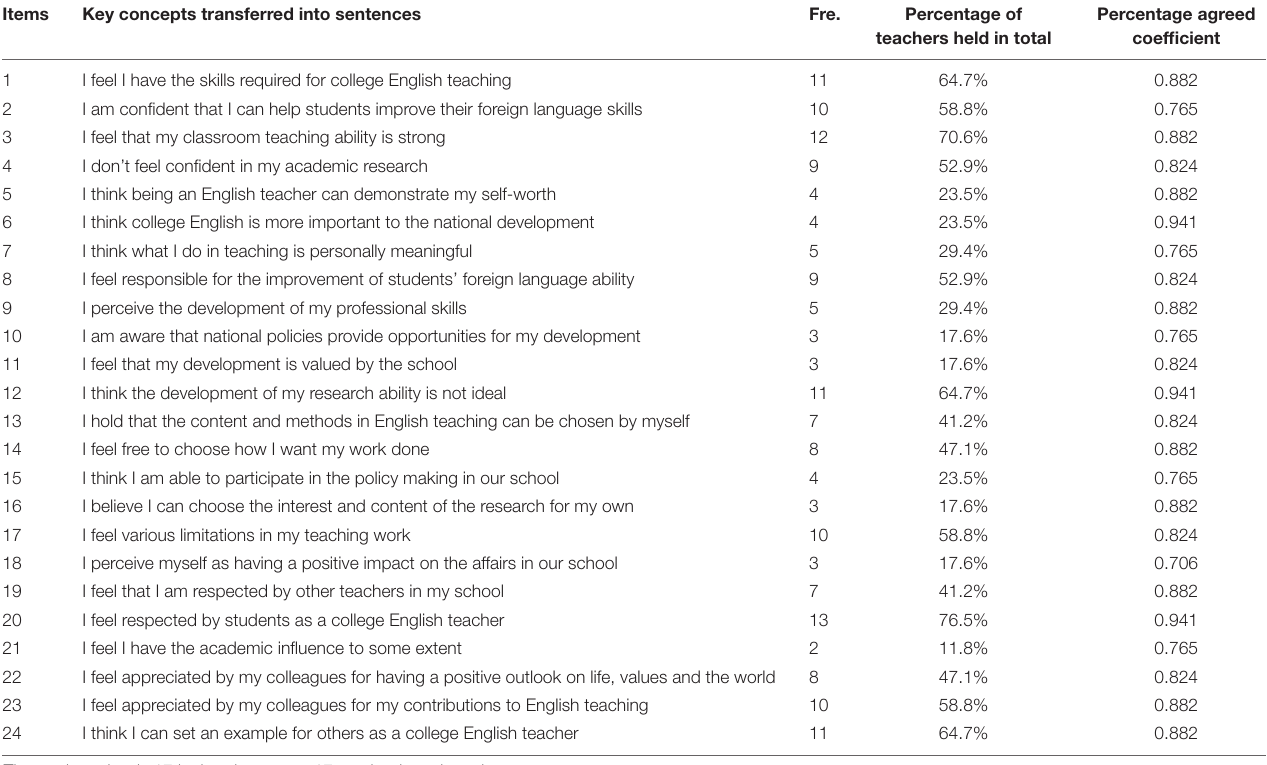
TABLE 2 | Descriptions in the initial CETPE scale (translated from the Chinese version). Items Key concepts transferred into sentences